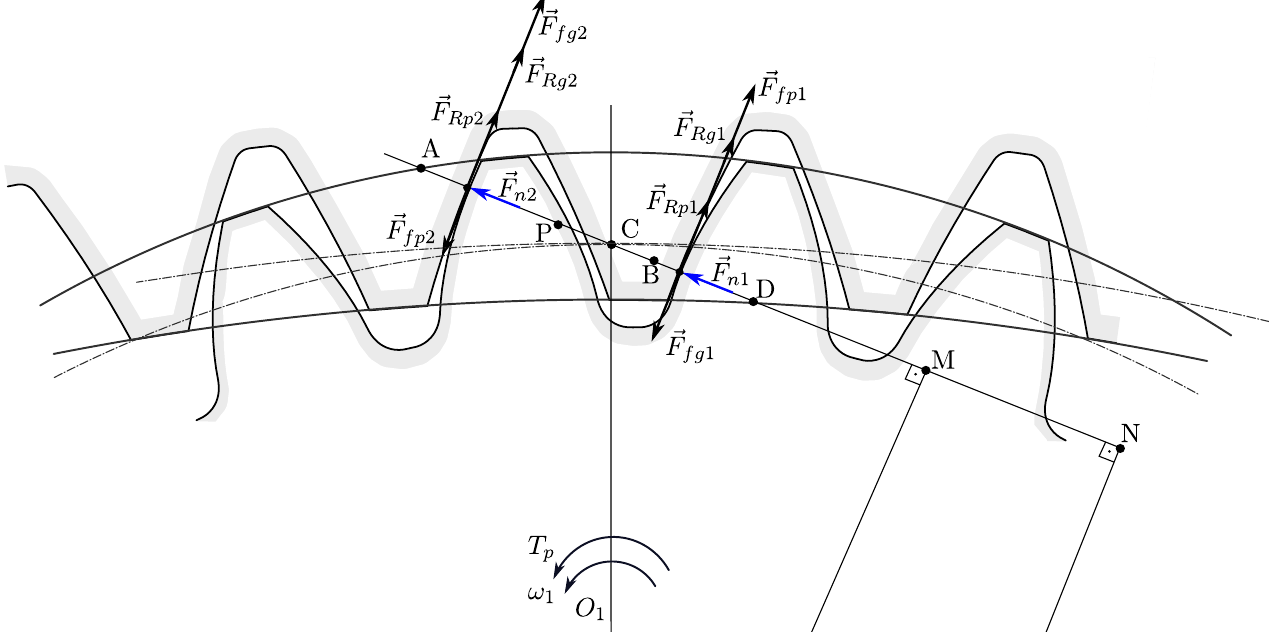
Figure 2. Forces acting upon gears during the meshing process of a gear